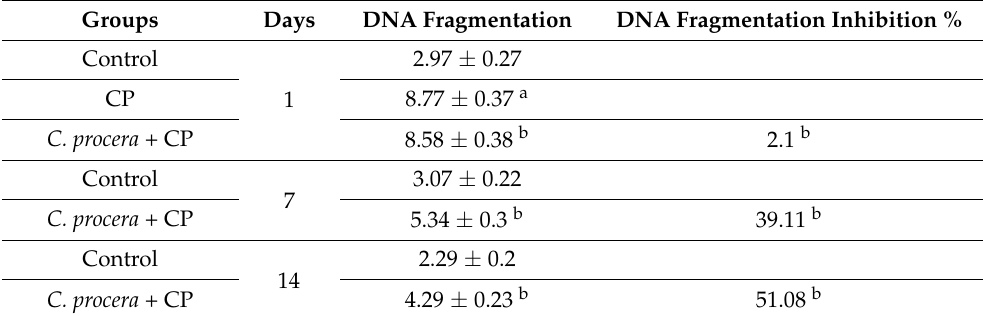
Table 7. DNA fragmentation in mouse liver cells after treatment with C. procera 200 mg/kg for 1, 7 and 14 days alone or in combination with cyclophosphamide 20